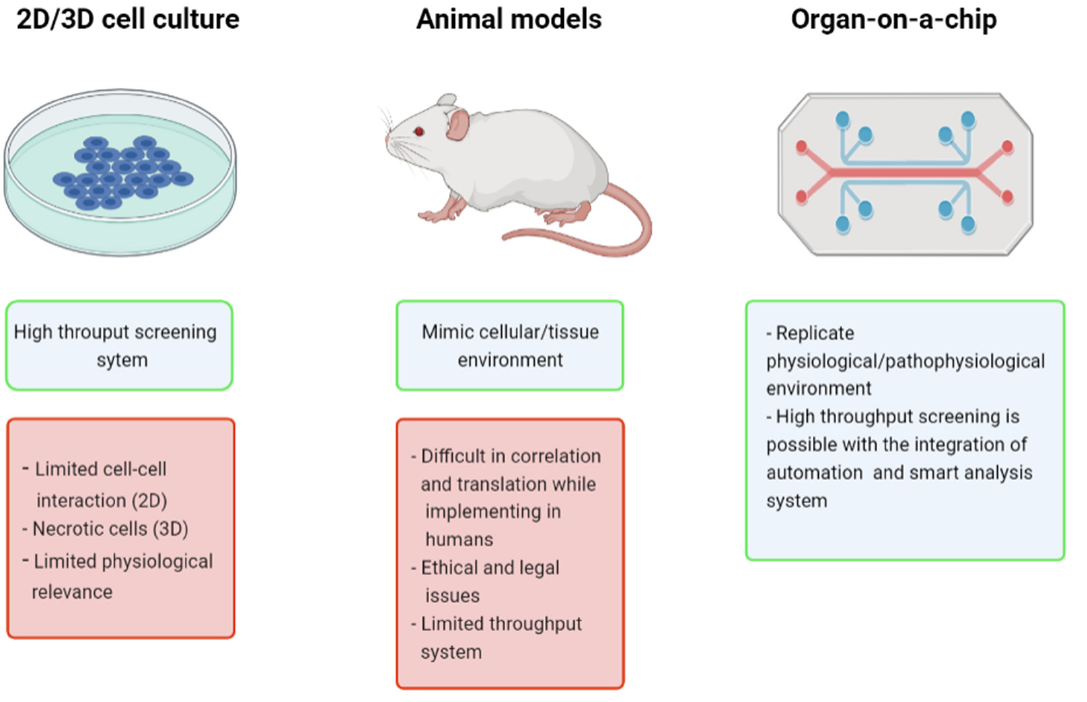
Figure 1. Some of the advantages of OOAC technology over cell cultures and animal models. Figure generated using BioRender.com (accessed on 16 May 2022).